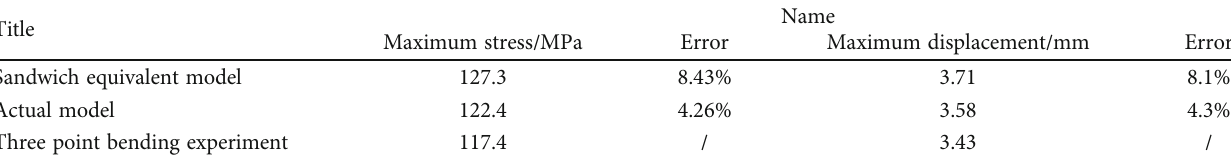
Table 5: Comparison of FEM simulation results and experimental results for three-point